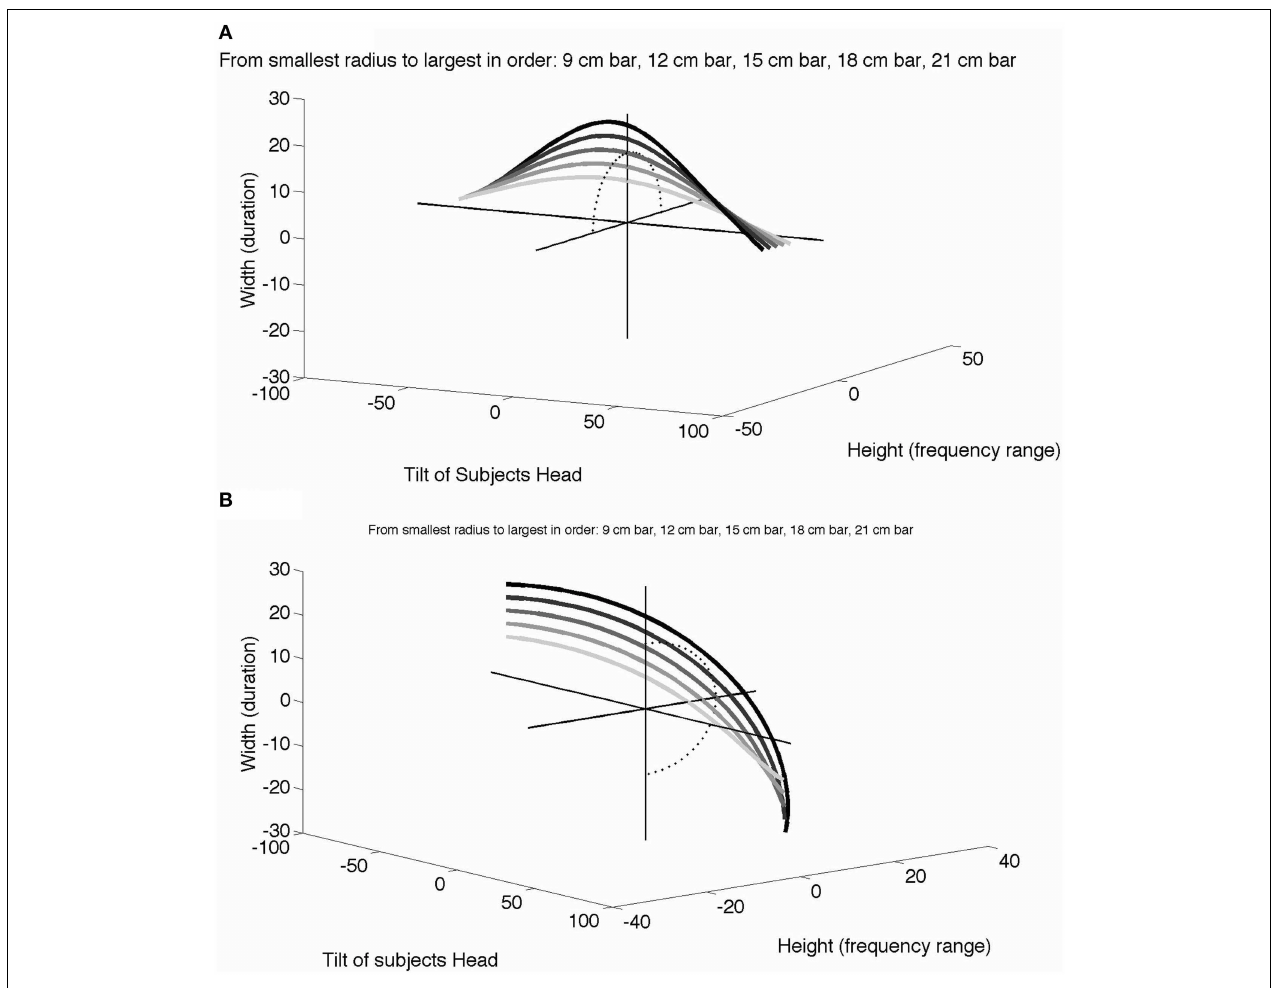
ranging from 9 to 21cm in length. The sets of curves are viewed from different 3D perspectives in each case for clarity. A dotted half circle is drawn on the height-width plane to show the projection of the 15cm curve (i.e., the shape of the 15cm curve without head tilt or the x-axis) in both figures. Additional plot details in Video S1 and Video S2